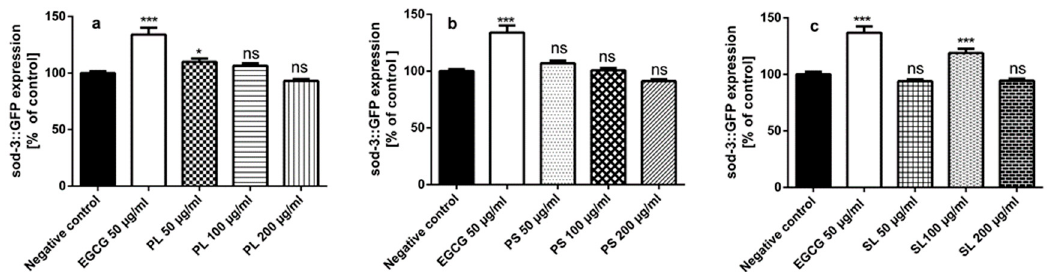
Figure 6. sod-3::GFP Expression in the mutant strains CF1553[(pAD76)sod-3::GFP + rol-6] after pre-treatment with the extracts, EGCG (epigallocatechin gallate) and extracts of PL ( P. alba leaf), PS ( P. alba shoots) and SL ( S. subserrata leaf). (a) Pre-treated mutants CF1553 with 50 µg/mL PL exhibited higher levels of sod-3 gene expression in comparison with control untreated worms. (b) PS showed no significant effect on sod-3 expression in mutants CF1553 compared to the untreated control. (c) Pre-treated worms CF1553 with 100 µg/mL SL showed higher levels of sod-3 gene expression in comparing to control untreated worms. The results are presented as mean ± SEM ( n = 3). ns (not significant) p > 0.05, * p < 0.05, *** p < 0.0001, analyzed by one-way ANOVA followed by Bonferroni